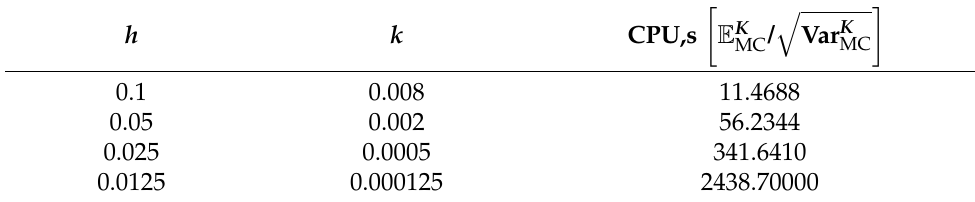
Table 4. CPU time (in seconds) spent to compute the approximations to the expectation (mean), (cid:113) E K , and the standard deviation, Var K in Table 2, for a fixed time horizon T = 1 and K = 1600 MC MC MC simulations but varying the temporal step-size k and the spatial step-size h in the domain [ 0 + h ,1 − h ]